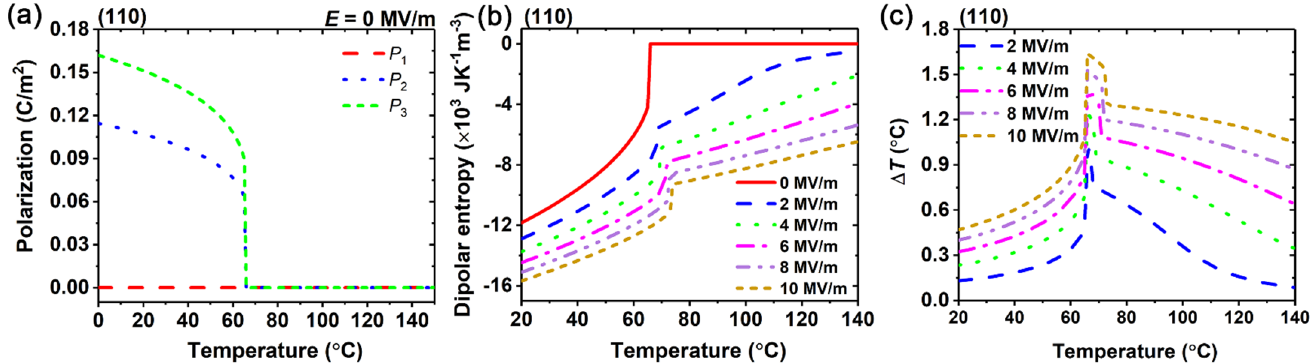
Figure 2. ( a ) Polarizations of (110)-oriented BaZr 0.15 Ti 0.85 O 3 in the absence of an external electric field. ( b ) Dipolar entropy and ( c ) adiabatic temperature change Δ T under different electric fields as a function of temperature.